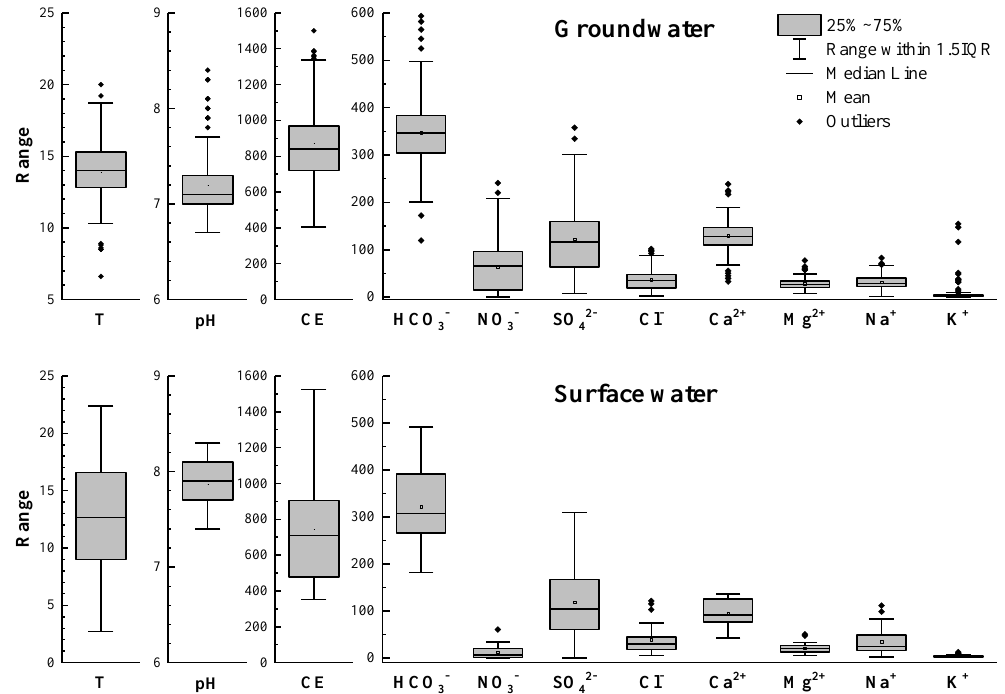
Figure 2. Box plot of hydrochemical data for groundwater samples ( top ) and surface water samples ( bottom